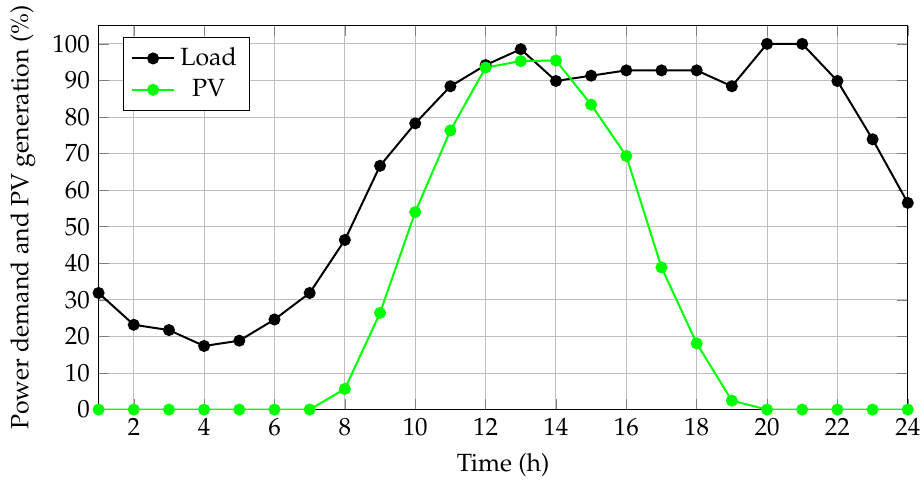
Figure 3. Average behavior of PV generation and power demand in Colombia during a normal day